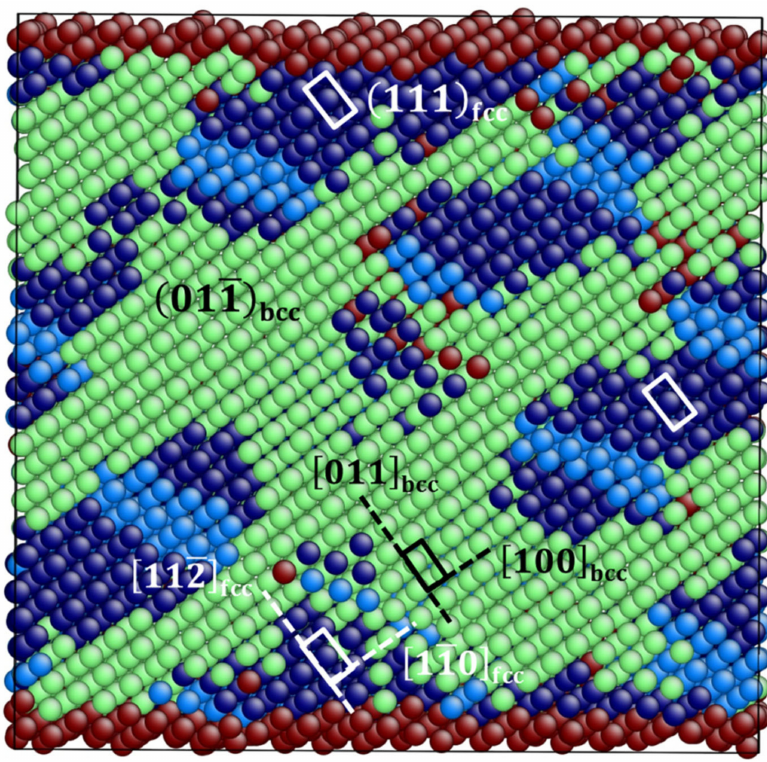
Figure 13. A zoomed snapshot of the ongoing austenitic phase transition in film 3 at 800 K, where the parent bcc phase, the fcc phases nucleated at the upper and lower surfaces and in the bulk material coexist. This figure corresponds to the status at a shear angle of 15.6 ◦ . The colors denote the local crystal structure as in Figure 5. The plane as shown in this figure is the original (011) bcc plane, which transforms to the (111) fcc plane. The black rectangle indicates a unit cell on the (011) bcc plane and the white rectangles display three units cells on the (111) fcc planes. The fcc phases indicated by the white rectangles are nucleated at the upper and lower free surfaces and in the bulk material,